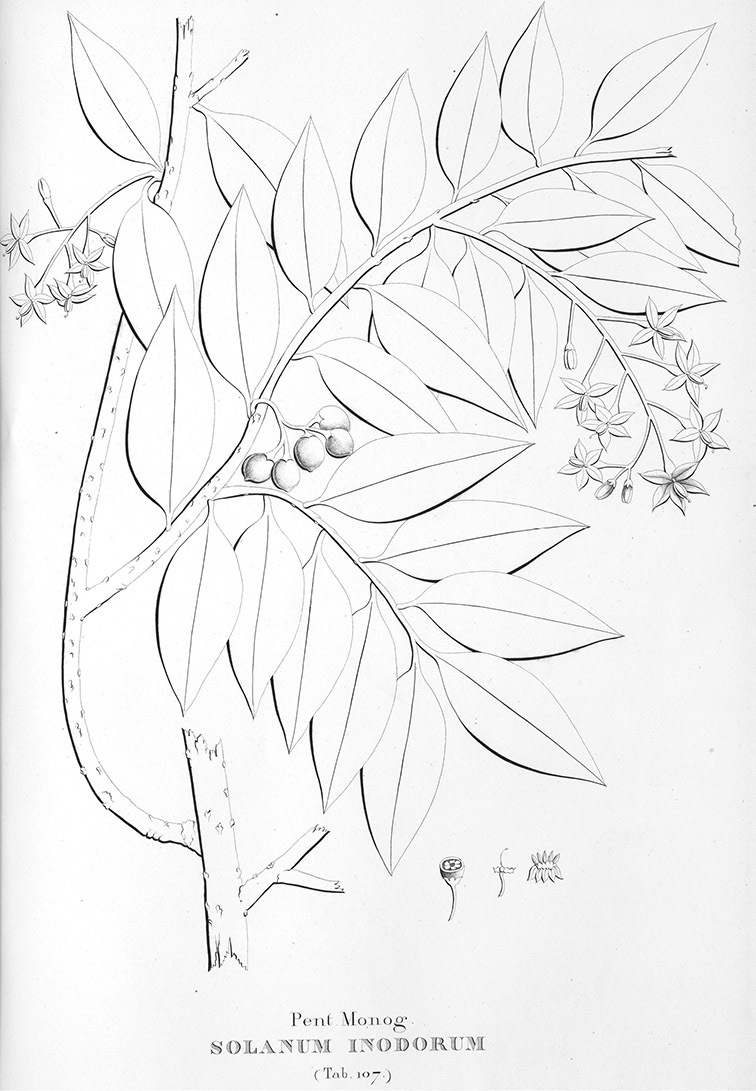
Lectotype of Solanum inodorum Vell. (Vellozo 1831: tab. 107). Reproduced with permission of the Natural History Museum Botany Library.